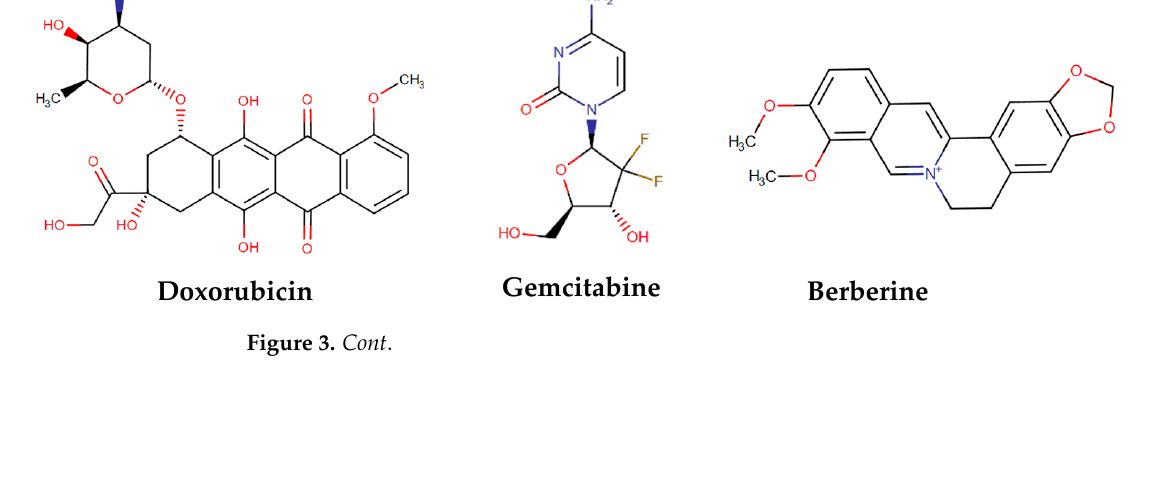
Figure 3. Chemical structures of the released drugs in drug delivery systems [80]. 4.1.1. Chitosan Fibrous Structures as Localized Drug Delivery Systems for Cancer Treatment Chitosan (CH) is a cationic polysaccharide derived from natural chitin. CH is a bi- opolymer widely used in biomedical applications due to its biocompatibility, biodegrada- bility, non-toxicity and water-solubility [34,81,82]. It is easily manufactured into different forms, namely as nanofibers [81,82]. Sanpui et al. developed a silver nanoparticle–CH nanocarrier and tested its cytotoxic effect on colon cancer cell lines. After treatment with this nanocarrier, cells were examined by fluorescence and scanning electron microscopy (morphological) and cell viability assay and flow cytometry (biochemical) to verify whether cell apoptosis had occurred. It was concluded that the use of low concentrations (24–48 µg mL − 1 ) of silver nanoparticles-CH nanocarriers induced cell apoptosis, indicating its potential for use in cancer therapy [54]. Yan et al. successfully manufactured poly(vinyl alcohol) (PVA) and CH nanofibers. The surface morphology and microstructures of the nanofibers were being altered by changing the proportion of feed between PVA and CH. In Figure 4 are represented TEM